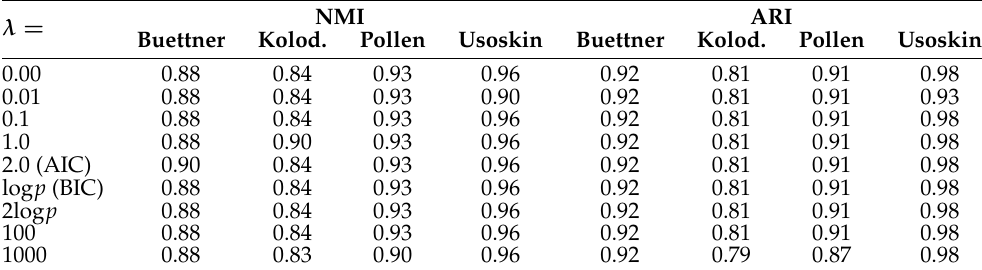
Table 1. RGGC performance measured with NMIs and ARIs with different values of λ for the 4 real scRNA-seq data (detailed information of the 4 data is introduced in Lines 123–132 on page 5), where the regulation parameter λ takes the values from 0 to 1000. NMI and ARI values are reported on the left- and right-sides of the Table, respectively, where higher value indicates better performance. NMI ARI λ = Buettner Kolod. Pollen Usoskin Buettner Kolod. Pollen Usoskin 0.00